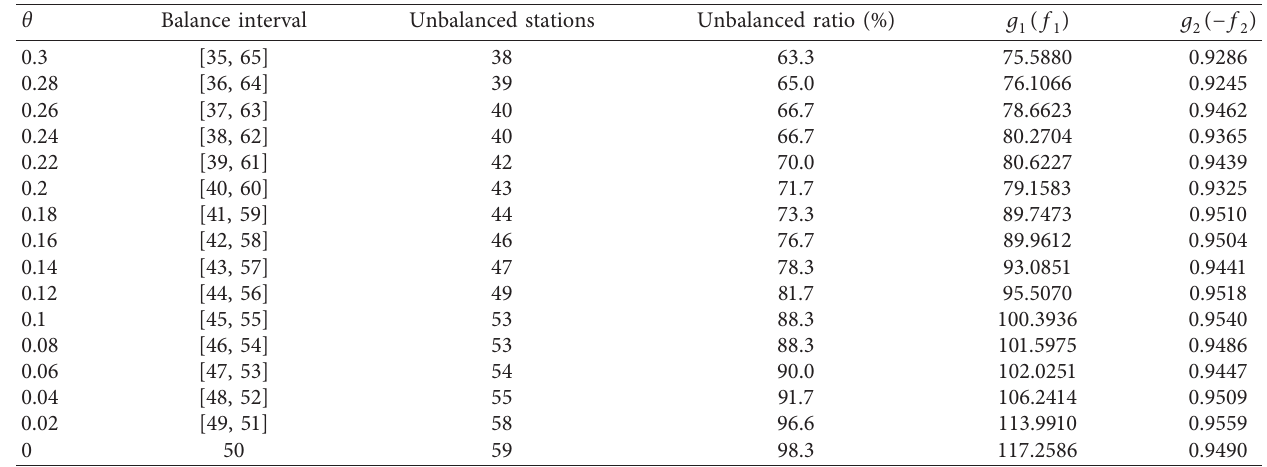
Table 8: Sensitivity analysis results of different θ